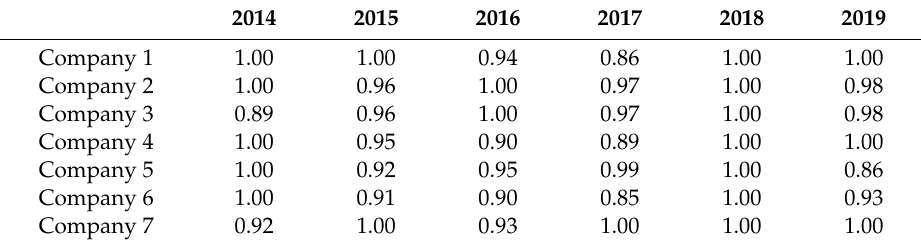
Table 7. Average e ffi ciency in FDH model for each